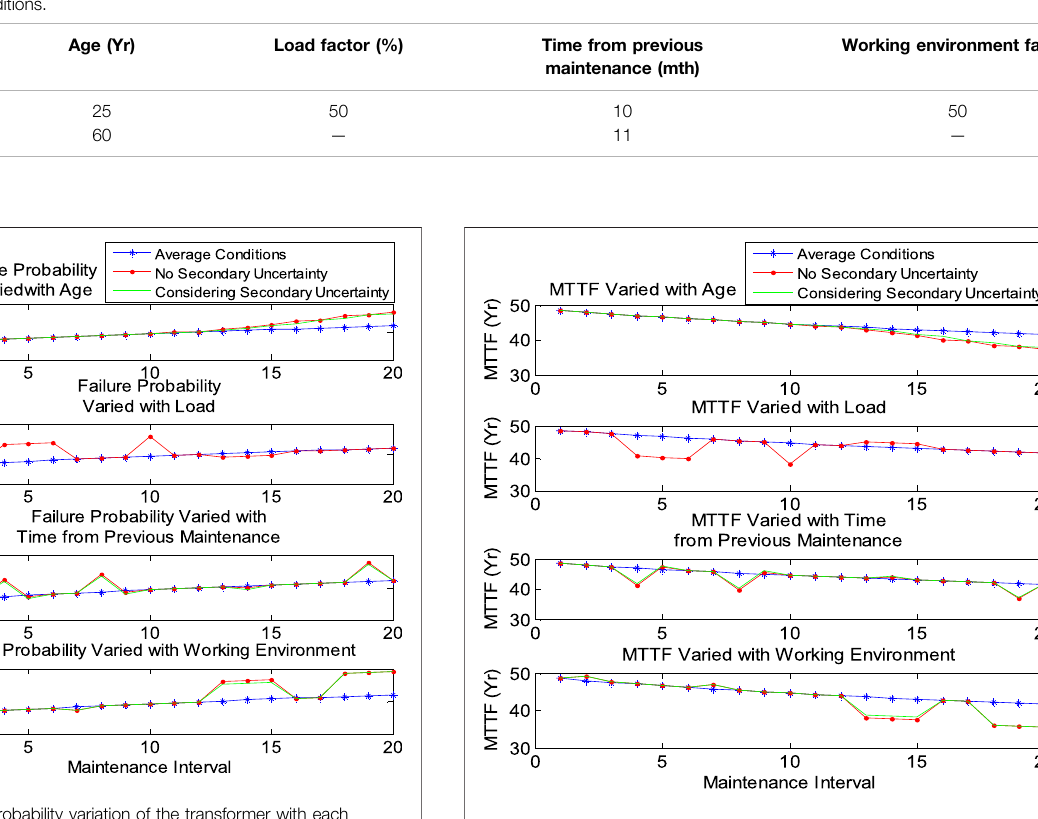
operation condition.